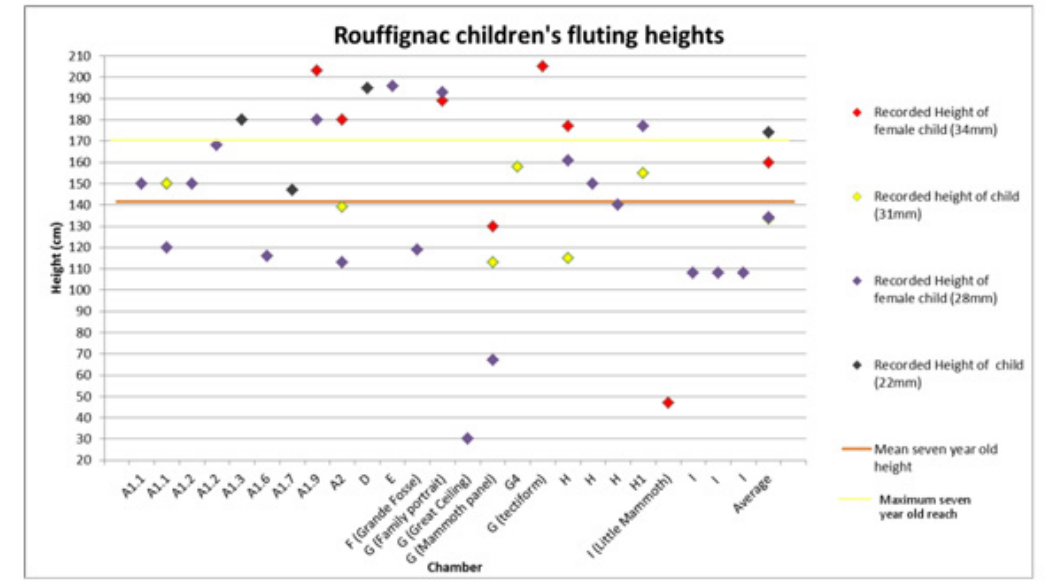
Figure 9. Rouffignac: childrens’ fluting